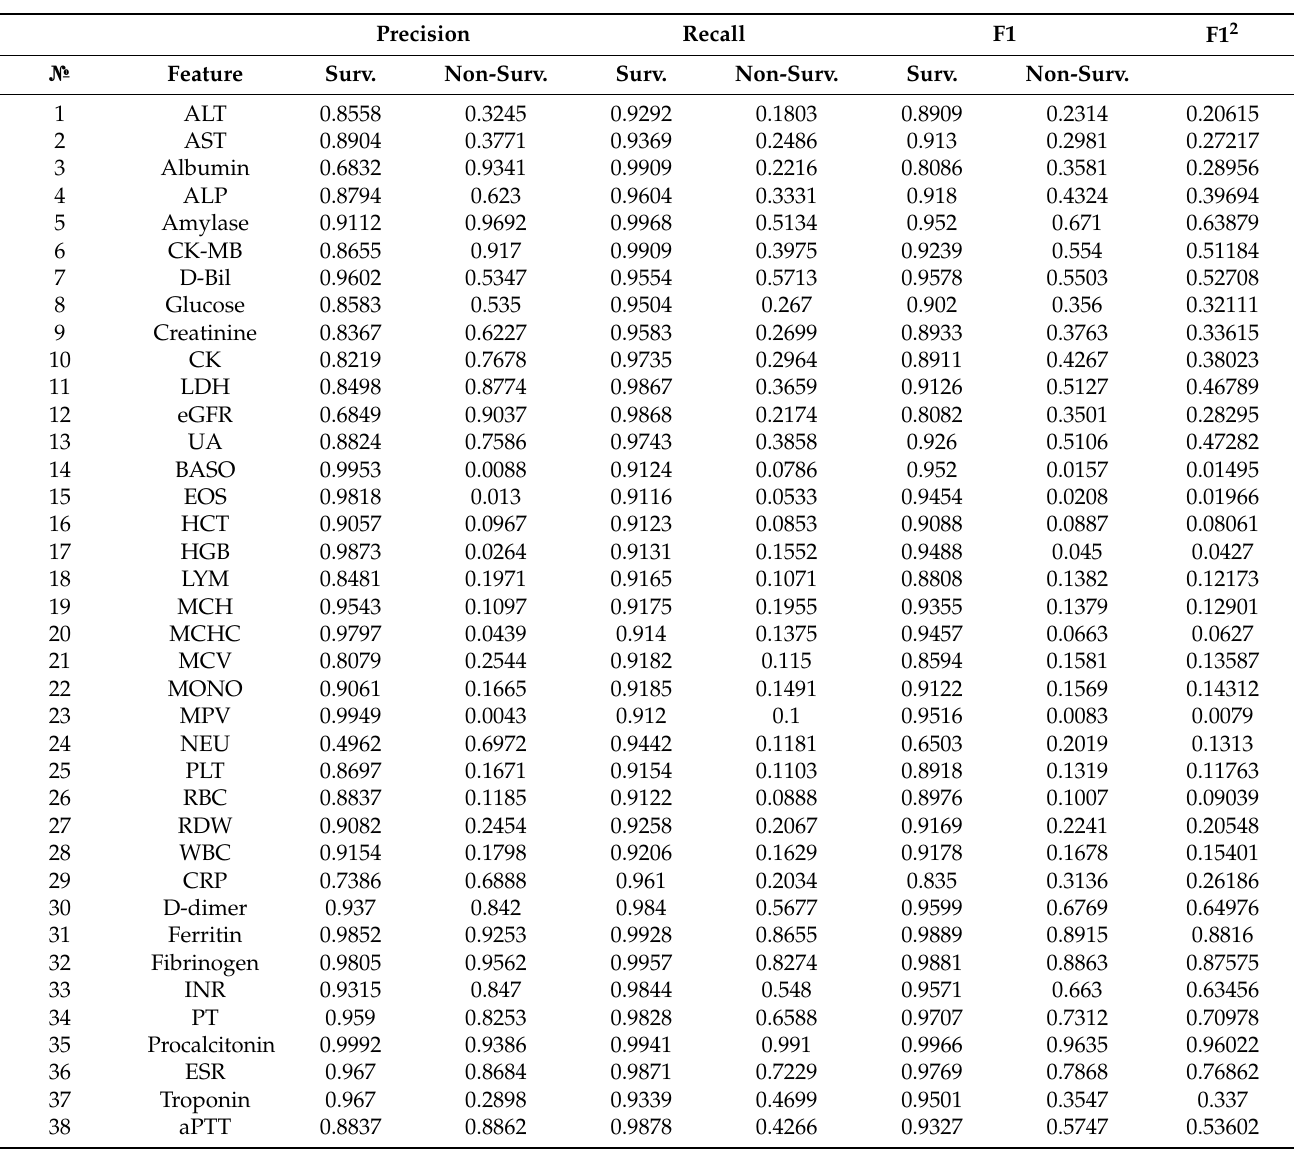
Table A1. The classification results of SARS-CoV-2-RBV3 dataset for the HGB model using a